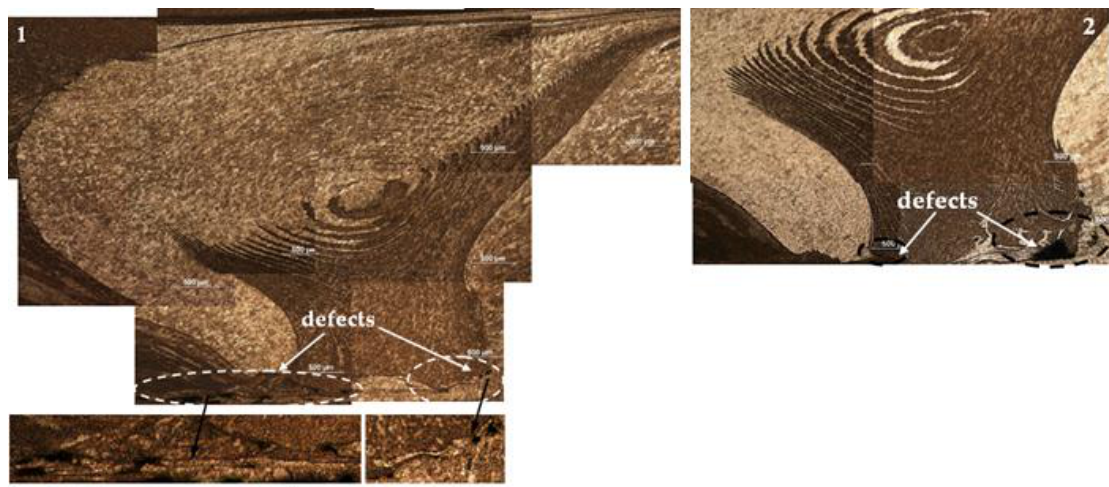
Figure 5. Samples for defective weld joints (Exp. 1 and Exp. 2).